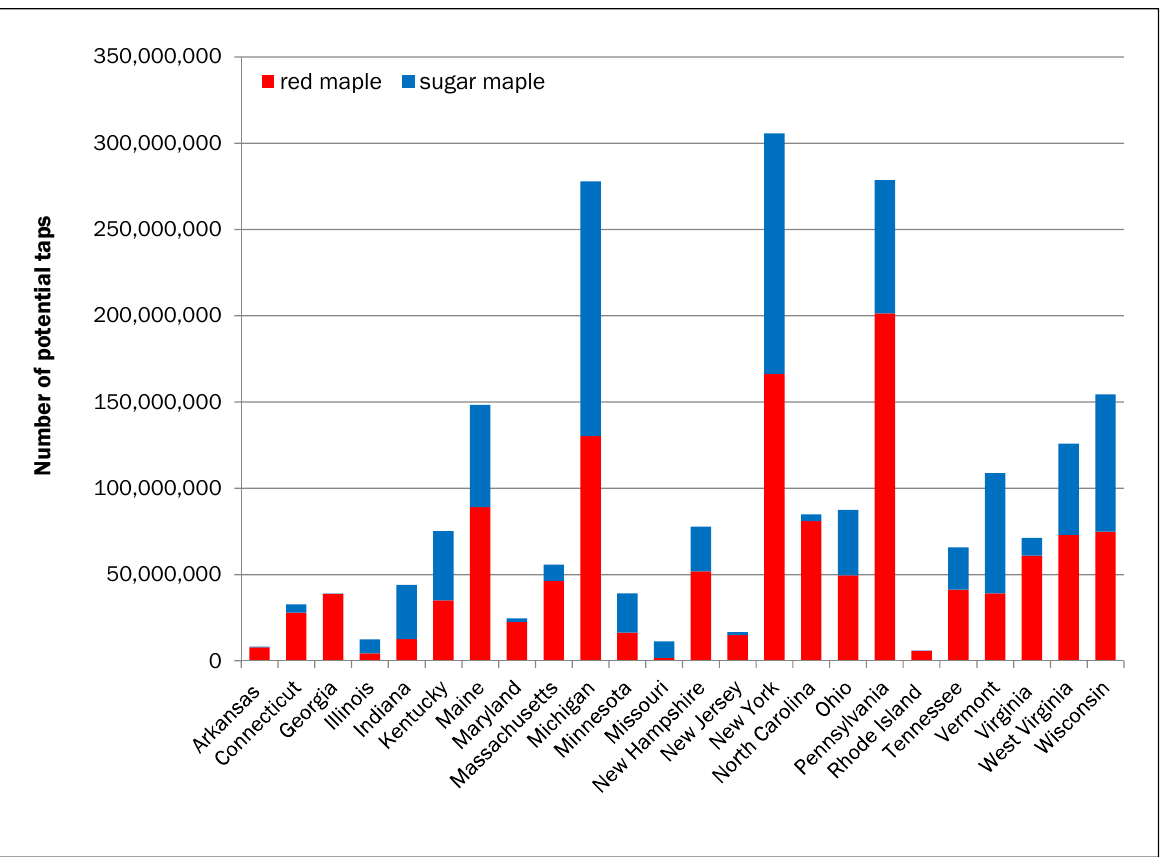
Figure 5. Total Number of Potential Sugar and Red Maple Taps for 24 States in the United States, 2011